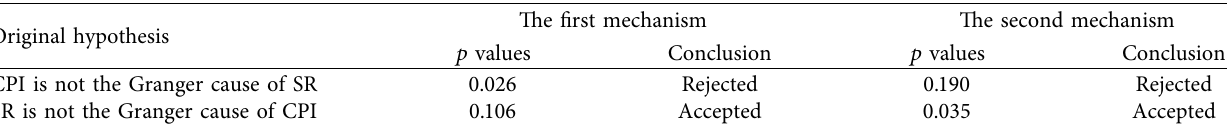
Table 8: Granger test results of threshold cointegration mechanism.